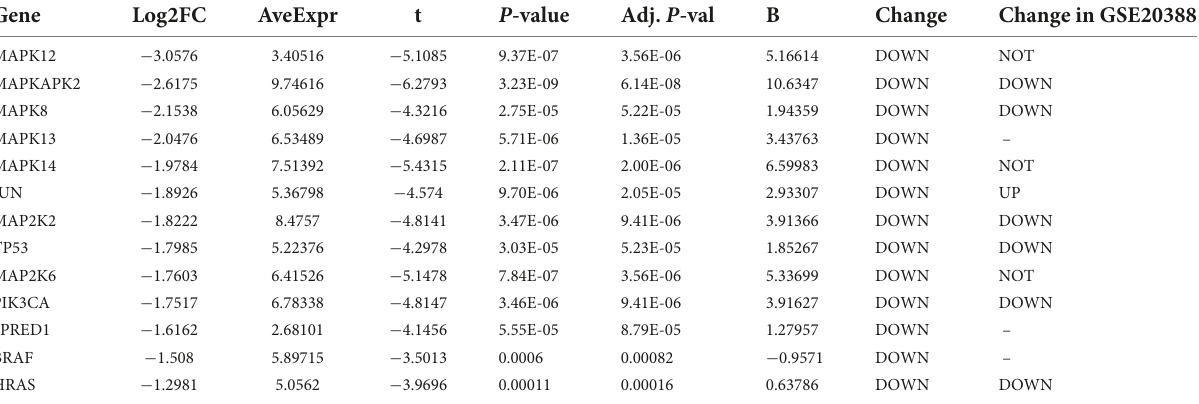
TABLE 2 DEGs identification from different clusters of